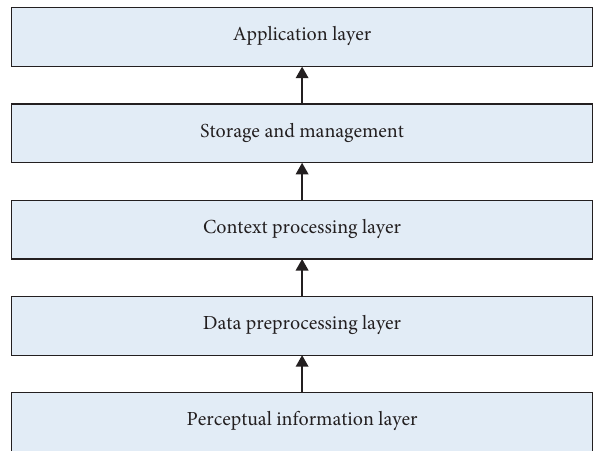
Figure 3: Context-aware computing framework